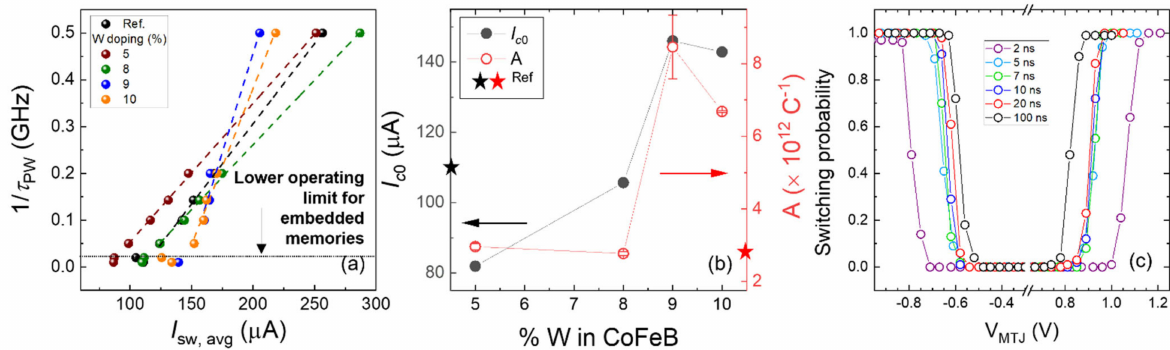
Figure 3. ( a ) Comparison of average write currents at different frequencies (1/ τ PW ) for the different FL stack options estimated from 2000 switching events/data point; ( b ) extracted critical switching currents ( I c0 ) and spin transfer efficiency ( A ) as a function of W doping concentration; ( c ) switching probability curves on showing 100% deterministic switching across the entire pulse duration testing range (2 – 100 ns) for FL = W 0.1 CoFeB 0.9